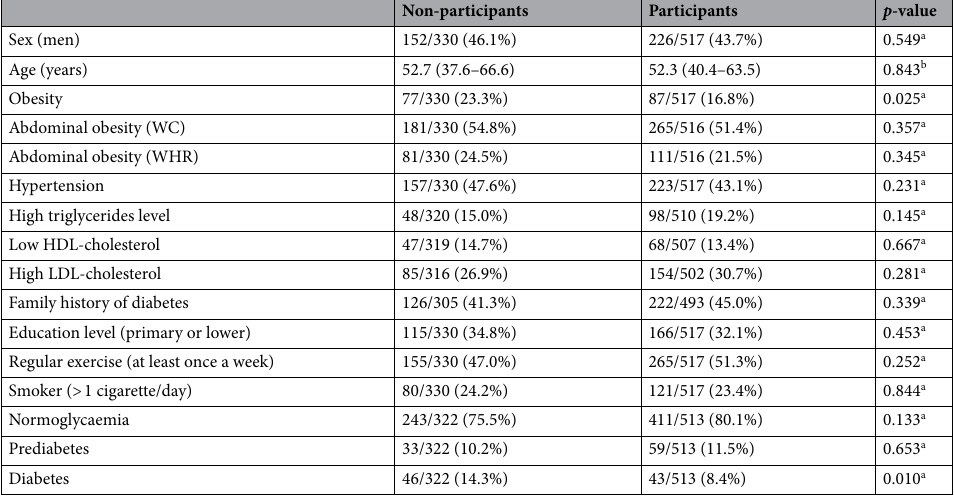
Table 1. Baseline characteristics of the population under study (2010–2012). Comparison between non- participants and participants in the follow-up. Age is shown as median (IQR: P 25 –P 75 ). Rest of variables is shown as n/total (%) where total is the number of non-participants or participants for each variable, as appropriate. Family history of diabetes defined as 1st or 2nd degree relatives with diabetes. Definitions of the rest of cardiovascular risk factors are detailed in methods. a Pearson’s Chi-square test. b Mann-Whitney